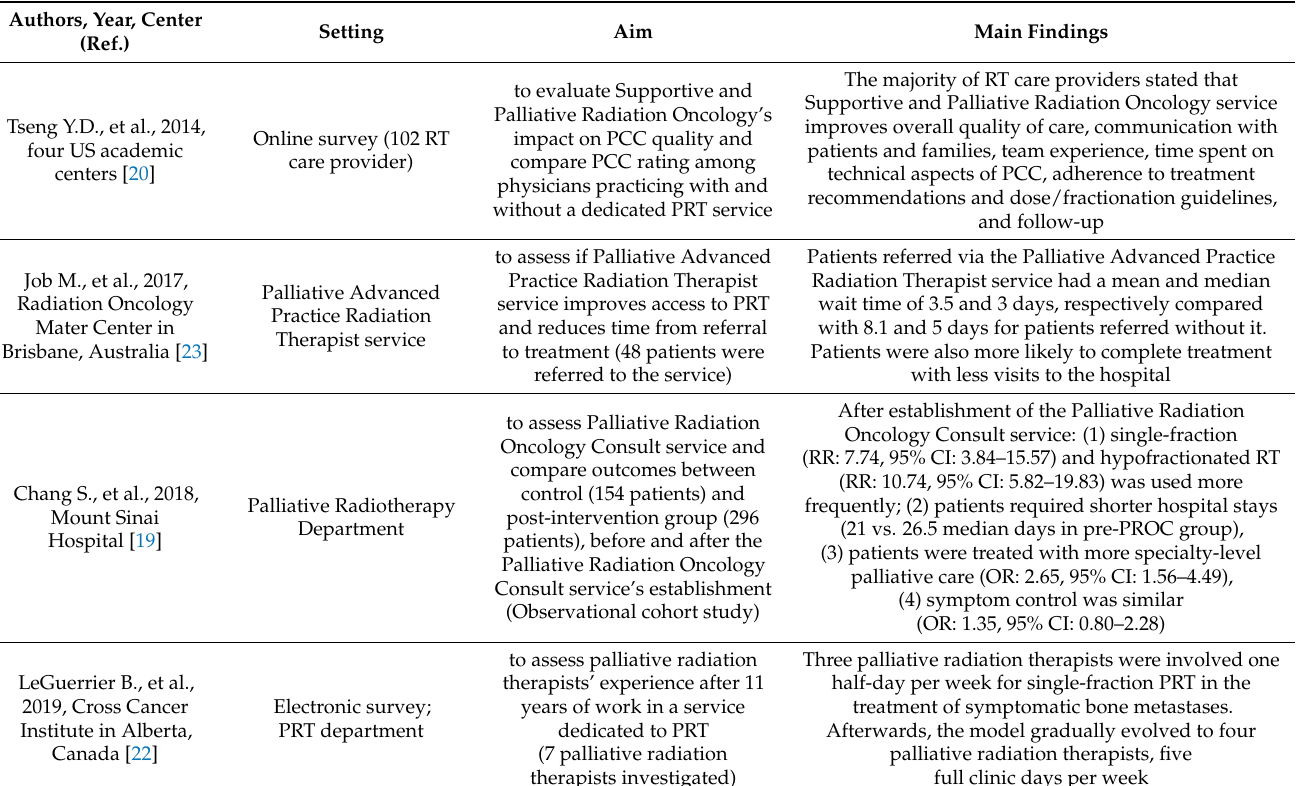
Table 1. Characteristics and main findings on studies on radiotherapy services dedicated to palliative